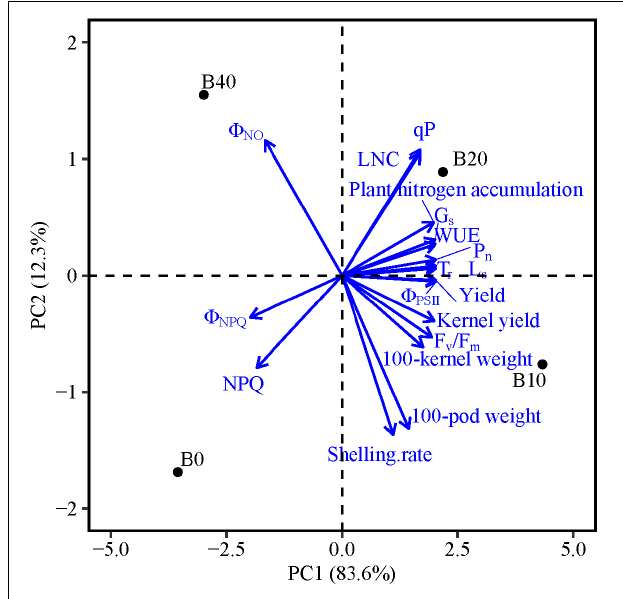
FIGURE 5 | Principal component analyses of chlorophyll fluorescence parameters, gas exchange parameters, leaf nitrogen content, yield, and yield components of peanut in response to four biochar application rates. Means for flowering and pod set are for 2 years. F v /F m , maximal efficiency of PSII photochemistry after dark adaptation; (cid:56) PSII , actual efficiency of PSII photochemistry after light adaptation; (cid:56) NPQ , quantum yield for energy dissipated via (cid:49) pH and xanthophyll-regulated processes; (cid:56) NO , quantum yield of non-regulated energy loss in PSII; qP, photochemical quenching; NPQ, non-photochemical quenching; P n , net photosynthetic rate; T r , transpiration rate; G s , stomatal conductance; L s , stomatal limitation;